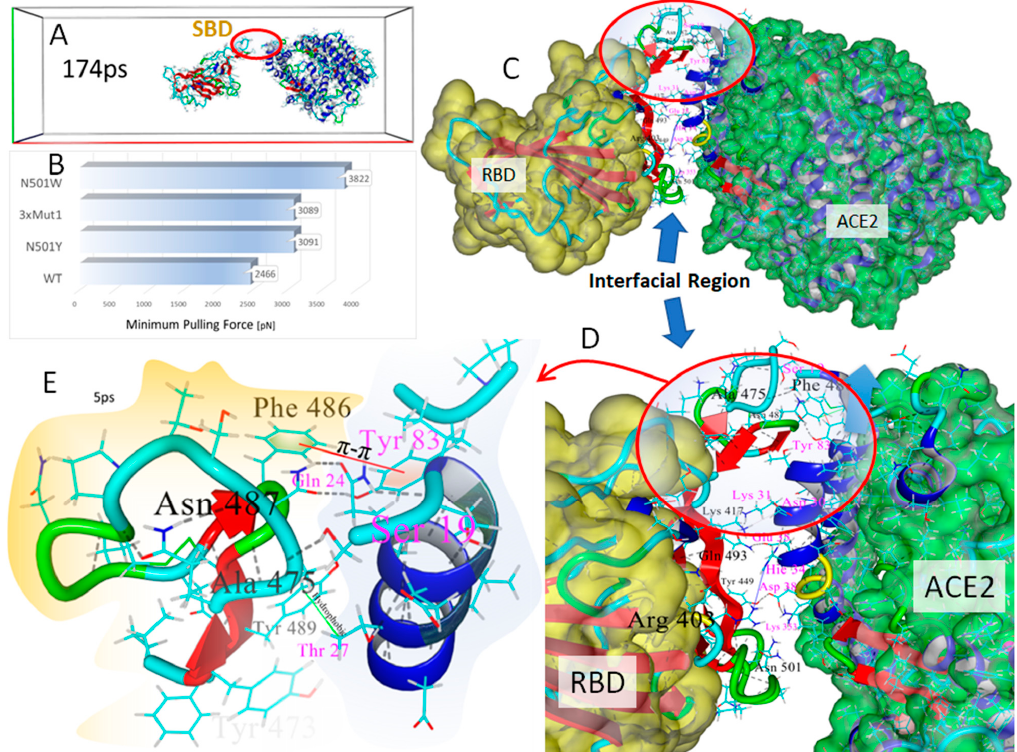
Figure 9. Interactions in the “strong binding domain” (SBD) of the wild-type RBD-ACE2 complex (6LZG). The SBD at the “top” of the interfacial region (circled in red) approximately comprised RBD residues 474–490 and ACE2 residues 19–22 and 78–83. The ACE2 SBD region is dominated by the two parallel alpha -helical regions that overlay the central zinc cavity of ACE2. ( A ) View of RBD-ACE2 complex at 174ps of SMD simulation time following near complete dissociation of the proteins. Note that the “strong binding domain” (SBD) was the last region to undergo dissociation. ( B ) Minimum pulling force (MPF) required for complete dissociation of the RBD-ACE2 complexes as a function of mutant type. ( C ) Wild-type RBD-ACE complex showing overview of interfacial zone after initial system equilibration and 104ps of SMD. RBD residue labels are shown as black; ACE2 labels as magenta. ( D ) Magnified view of interfacial region indicating significant intermolecular interactions, including: strong salt bridge from Arg402 of the RBD to Hie34 of ACE2 (blue line in ( D )); weak salt bridge from Lys417 of the RBD to Asp30 (gray-blue line in ( D )); π - π interaction between Phe486 of the RBD with Tyr83 of ACE2; hydrogen bond between the N-terminus Ser19 of ACE2 and Ala475 carbonyl oxygen of the RBD (dotted lines); hydrogen bond between RBD Tyr 449 -OH group and ACE2 Asp38; and hydrogen bond between the RBD Gln493 and ACE2 Glu35. ( E ) Detail view of some of the principle attractive interactions in the SBD. These include numerous stabilizing hydrogen bonds (dotted lines), as well as a strong π - π interaction between Phe486 of the RBD and Tyr83 of ACE2. Asn487 of the RBD was involved in two hydrogen bonds to the -OH group of Tyr83 of ACE2 and the terminal carbonyl group of Gln 24 of ACE2. A hydrophobic interaction exists between RBD Tyr489 and ACE2 Thr27. The hydrogen bond between Ala475 of the RBD and Ser19 of ACE2 helped stabilize SBD interactions and was often the last bond to undergo dissociation as the proteins were pulled